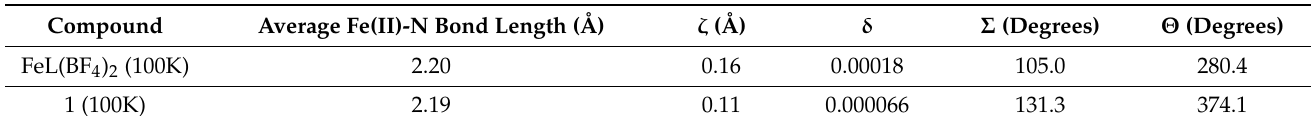
Table 2. Comparison of octahedral distortion parameters and average Fe-N bond lengths in FeL(BF 4 ) 2 ( 3 ) and the heterobimetallic cage ( 1 ). Figure 2. Crystal structure of the metalloligand FeL 2+ . Colour codes: Fe, orange; C, black; N, blue; H, white. Solvent and anions are not shown. ( a ) Single crystal structure of (lambda) metalloligand FeL 2+ . (side view), and ( b ) metalloligand FeL 2+ . Viewed down the C 3 axis. The cell direction vectors are to scale with the cell parameters in each projection.